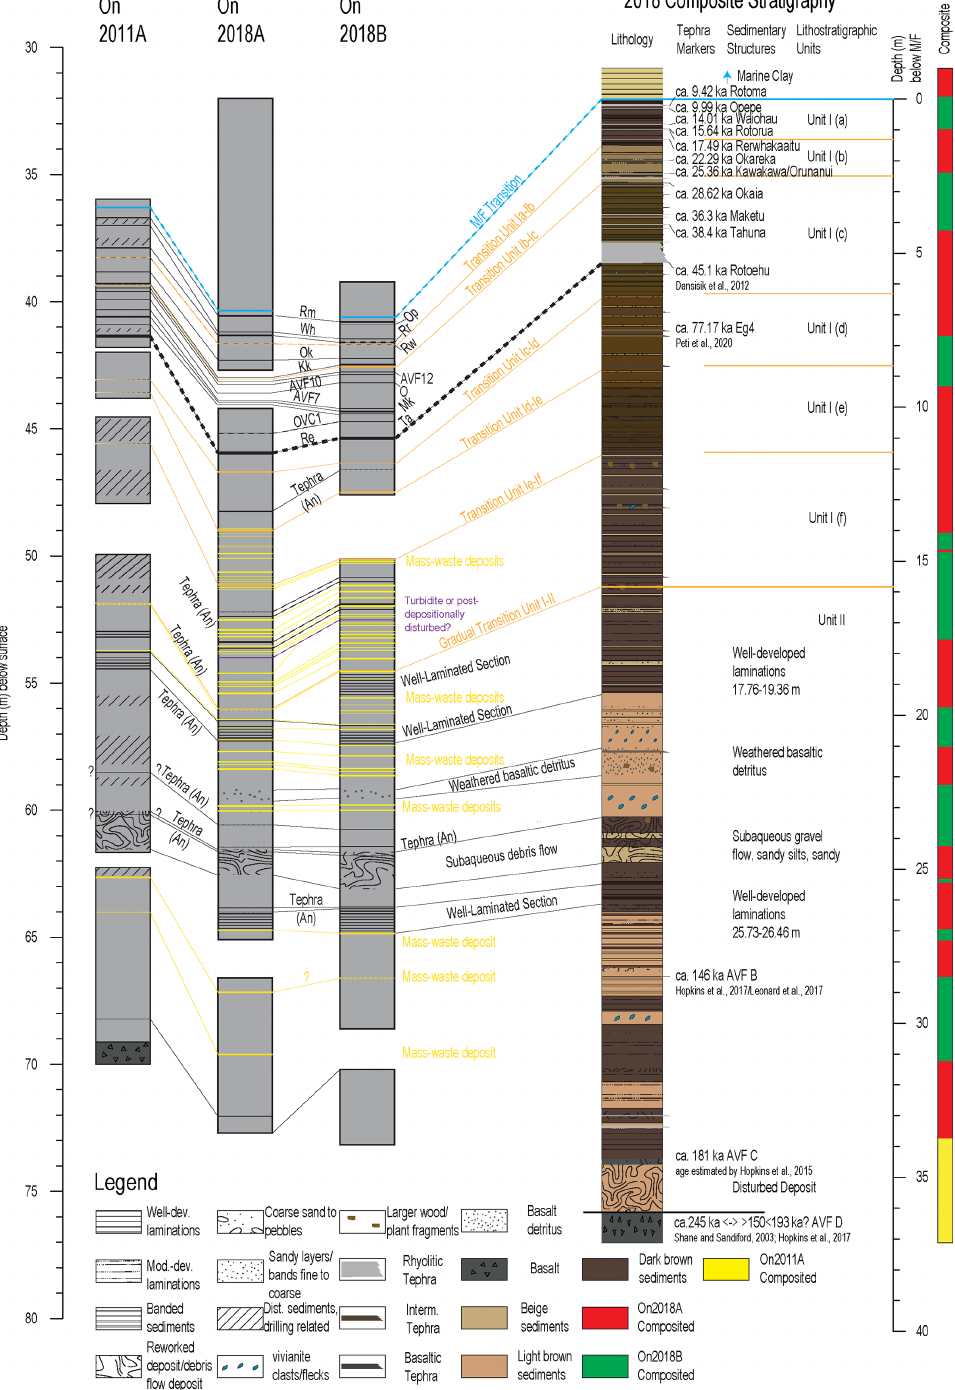
Figure 3. Onepoto maar palaeolake composite stratigraphy, lithological descriptions, and tephra marker layers. Tephra abbreviations: Rm = Rotoma; Wh = Waiohau; Rr = Rotorua; Rw = Rerewhakaaitu; Ok = Okareka; Kk = Kawkawa/Oruanui; Op = Opepe; AVF 12, AVF 10, AVF 7 = basaltic tephra, AVF sourced (Molloy et al., 2009); O = Okaia; Mk = Maketu; Ta = Tahuna; OVC1 = rhyolitic tephra, Okataina Volcanic Centre sourced (Molloy et al., 2009); Re = Rotoehu; An = andesitic tephra. Detailed lithostratigraphic descriptions are provided in Table S1 of the